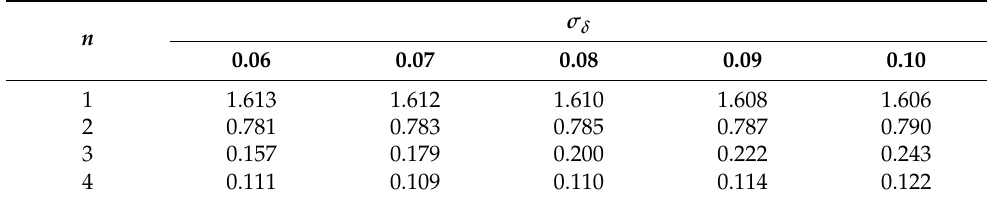
Table 2. Synchronization reduction factors C δ ( n ) .